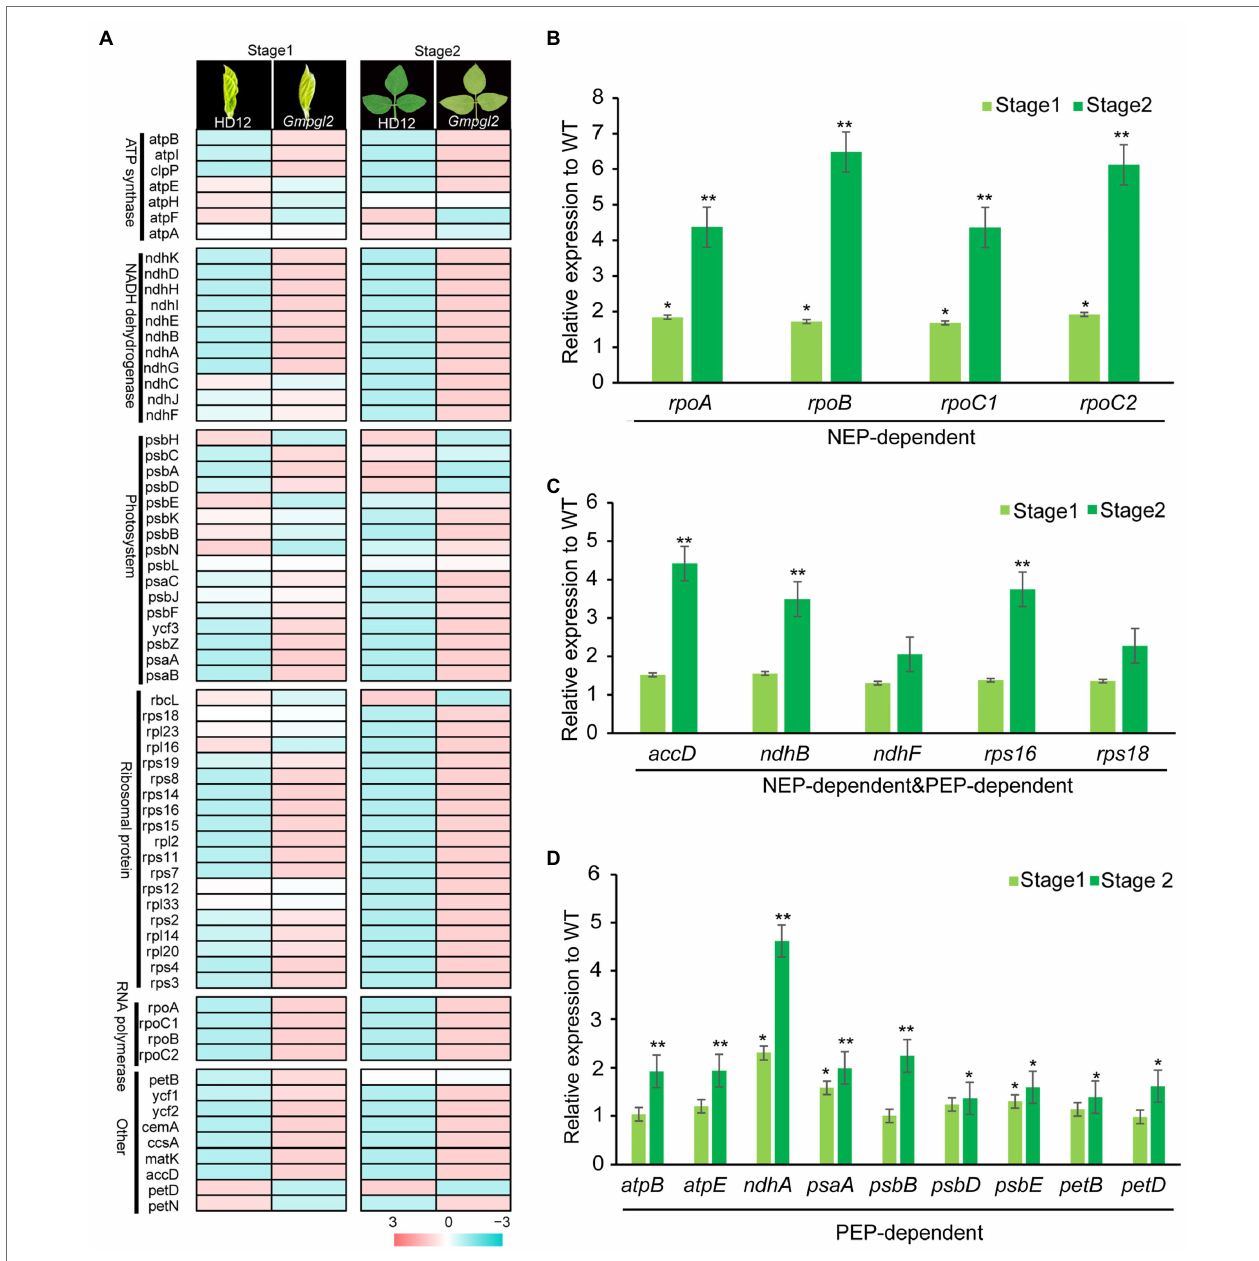
FIGURE 5 | (A) Expression of chloroplast genes in the leaves of 12-day-old (Stage1) and 18-day-old (Stgae2) HD12 and Gmpgl2 seedlings. (B-D) Comparison expression levels of chloroplast genes transcribed by NEP (B) , both NEP and PEP (C) , and PEP (D) between HD12 and Gmpgl2 seedlings. The values are the mean ratio ± standard deviation with three biological repeats. The asterisks indicate significant differences between WT and Gmpgl2 (Student’s test; * p < 0.05; * p <